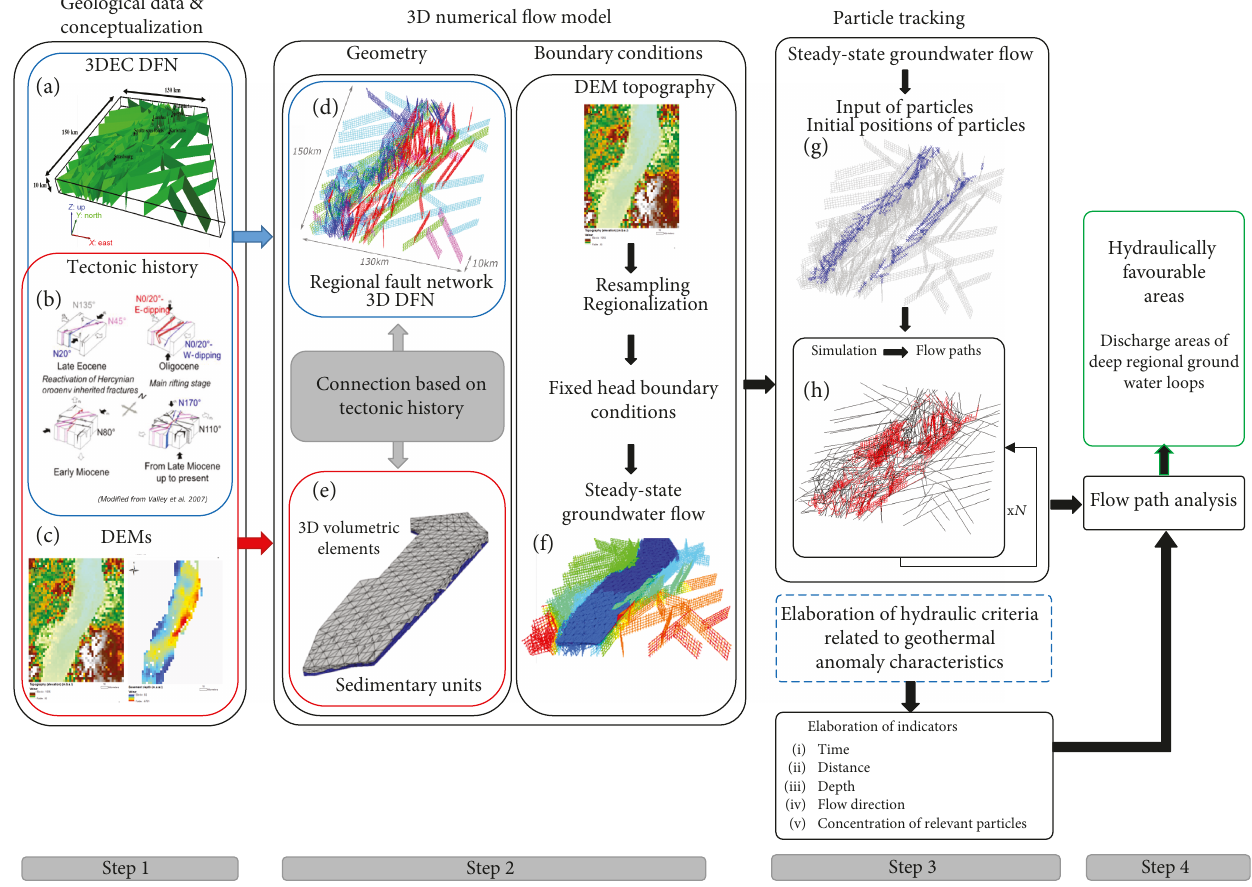
Figure 4: Main steps to build the fl ow model and locate preferential discharge areas at the URG